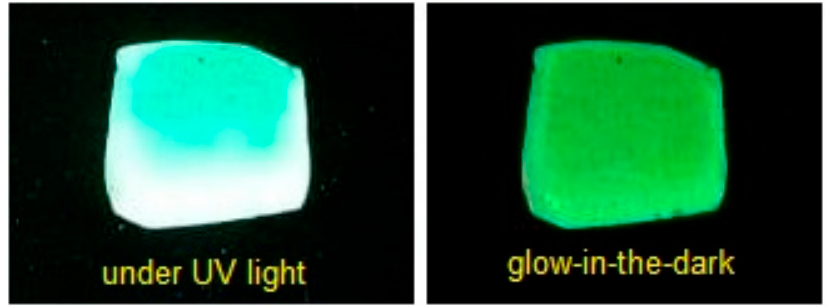
Figure 6. Photographs of LA 6 bellow UV illumination, and under darkness.